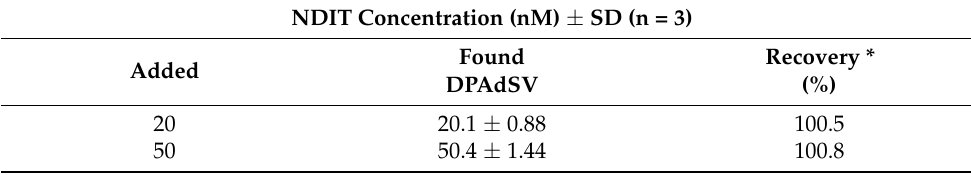
Figure 9. DPAdSV curves registered at the SPCE/SDS in 0.01 M solution of HNO 3 containing 10 mg/L SDS during human serum analysis: ( A ) (a) sample + 20 nM NDIT, (b) as (a) + 20 nM NDIT, and (c) as (a) + 40 nM NDIT; ( B ) (a) sample + 50 nM NDIT, (b) as (a) + 100 nM NDIT, and (c) as (a) + 150 nM NDIT. DPAdSV parameters: t of 45 s, Δ E of 175 mV, ν of 150 mV/s, and t m of 5 ms. Table 1. Results of NDIT determination in human serum samples.